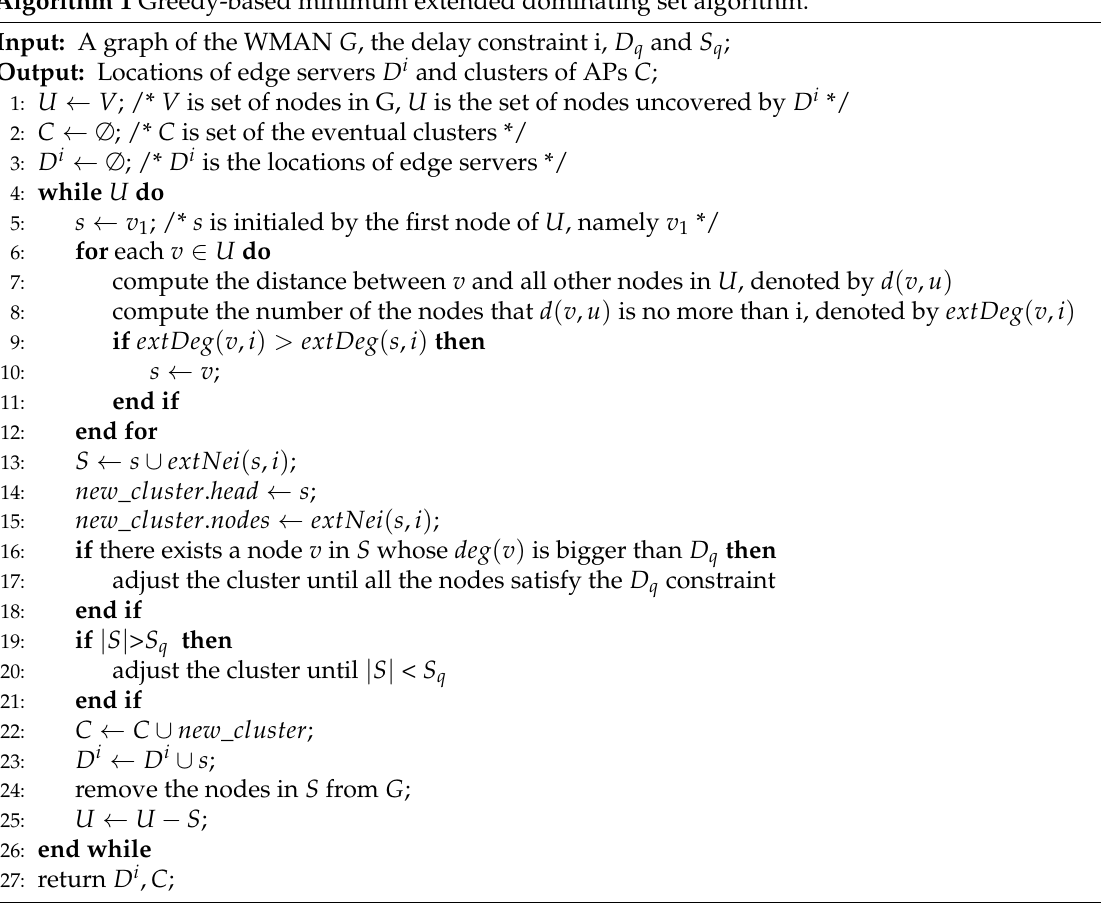
Algorithm 1 Greedy-based minimum extended dominating set